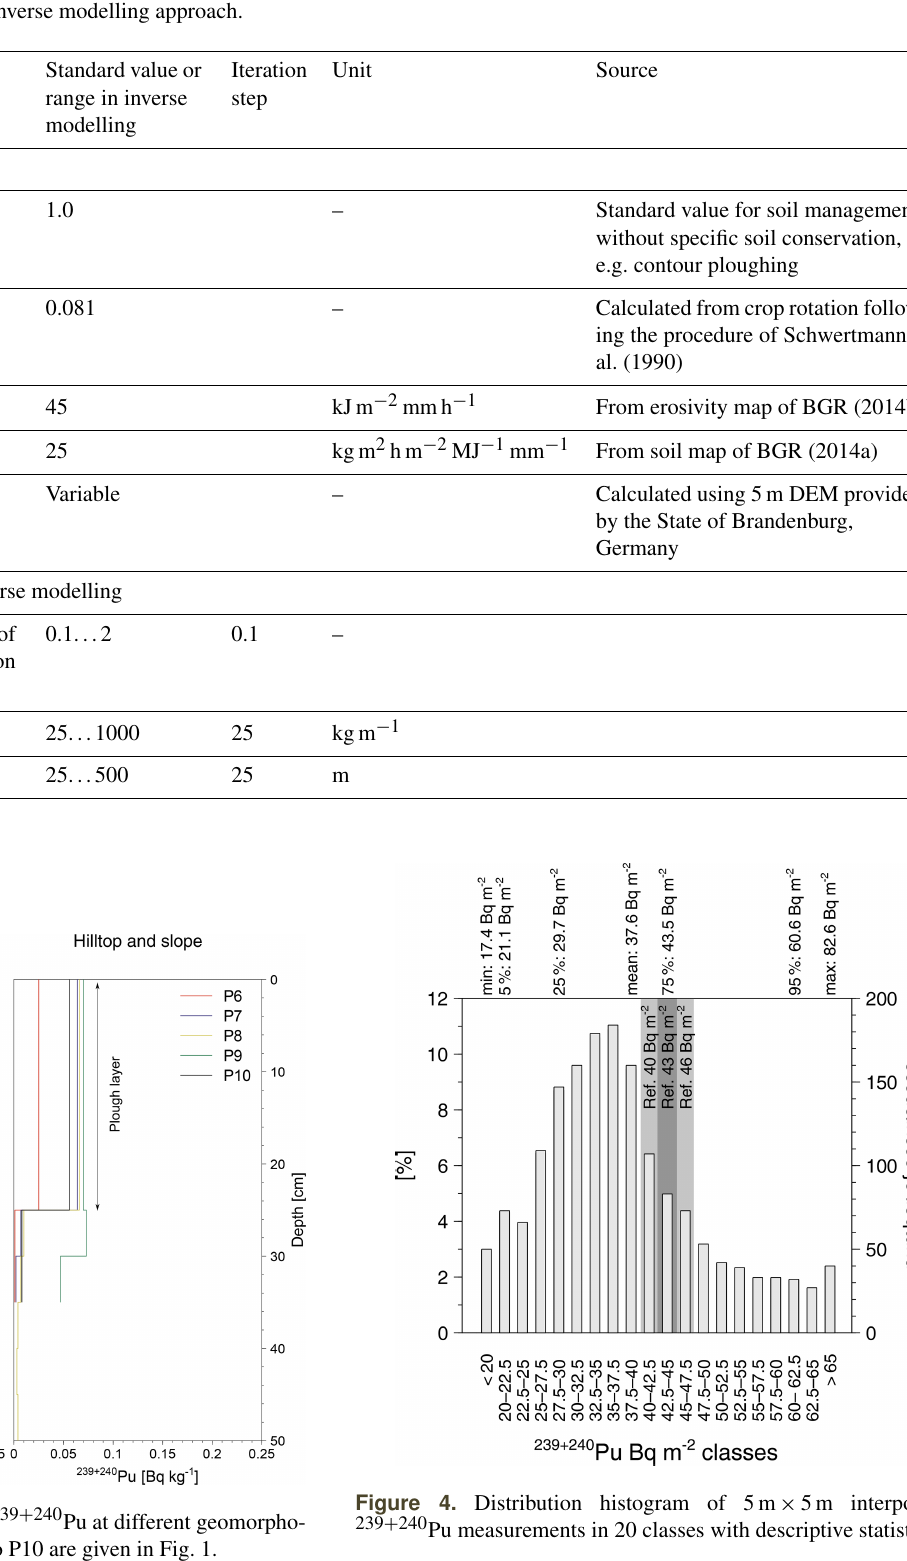
Table 1. Parametrisation of the inverse modelling approach.